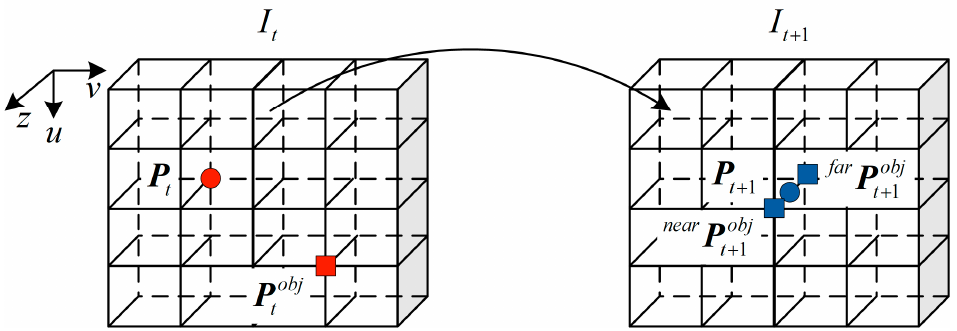
Figure 4. Diagram of mutual occlusion between dynamic objects and static structures. When a dynamic object and a static structure or multiple dynamic objects are in the same pixel, the pixel belongs to the one with the lowest depth.